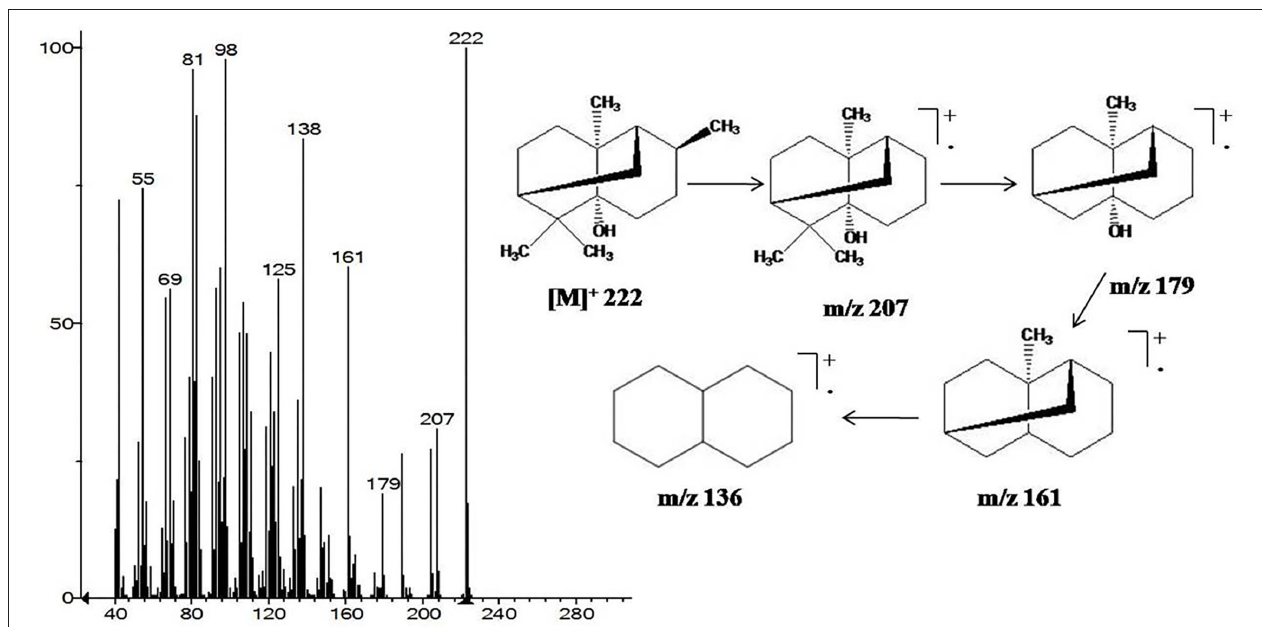
FIGURE 1 | GC-MS fragmentation pattern of the most abundant patchouli alcohol characterized in EO and HE of P.